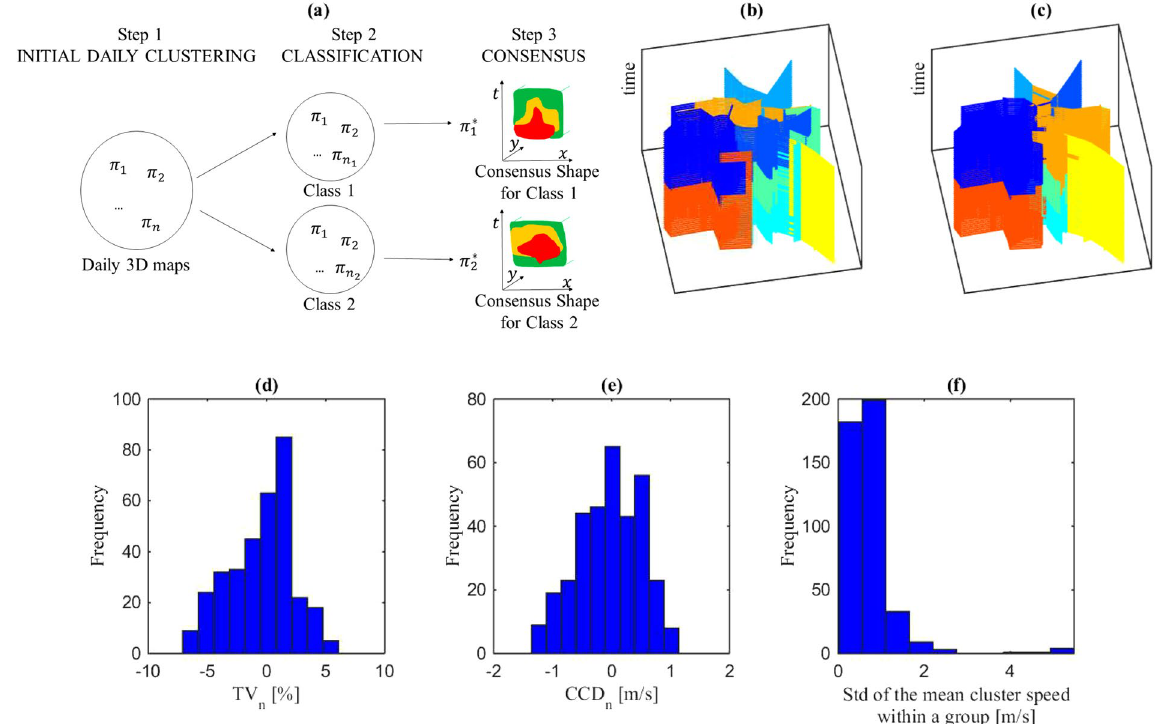
Figure 3. Classification of multiple days and congestion patterns identification for training sets. ( a ) The three steps to obtain consensual 3D speed maps ( b ) Original clustering for a particular day ( c ) Consensus clustering for the same day ( d ) Variation of TV n between the original and the consensual cluster shapes for all days and all replications of the training set ( e ) Variation of CCD n between the original and the consensual cluster shapes for all days and all replications of the training set ( f ) Distribution of the standard deviation of the mean cluster speed within a group of days (one value per cluster ID, group and replication). ( d ) and ( e ) Show that in most case switching from the original to the consensus shapes for a day has minor to acceptable impacts on the TV n and CCD n values. This means that the consensus shapes can be considered as a good proxy for the clustering of each day. ( f ) Shows that the consensus shape is also relevant to identify homogeneous regions in speed within a group as the standard deviation of the mean cluster speed remains below 0.5 m/s for the vast majority of